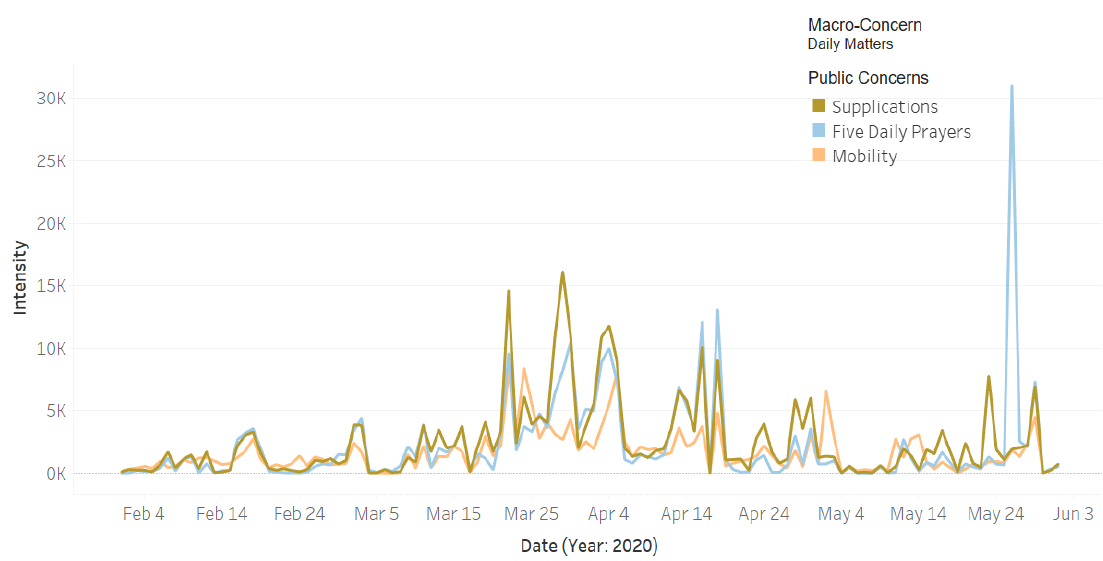
Figure 10. Daily Twitter activity for a public macro-concern (impact on daily life).